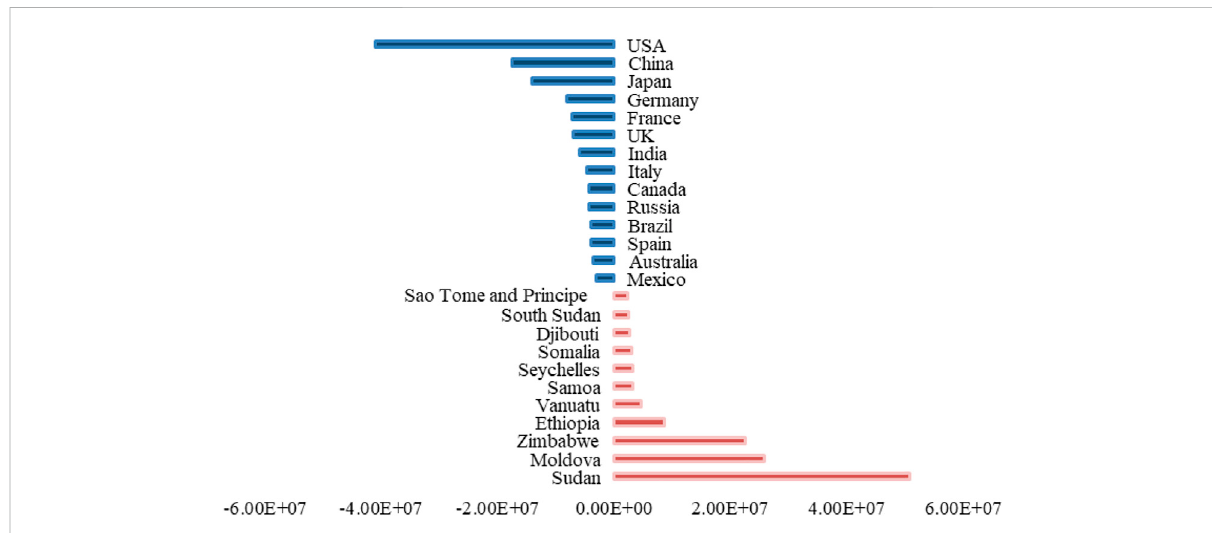
FIGURE 5 Top net importers and exporters of biodiversity threats. Note: The scores were calculated from the average value of the scores in each country from 2006 to 2015. Negative values indicate net imports of biodiversity, whereas positive values indicate net export of biodiversity.